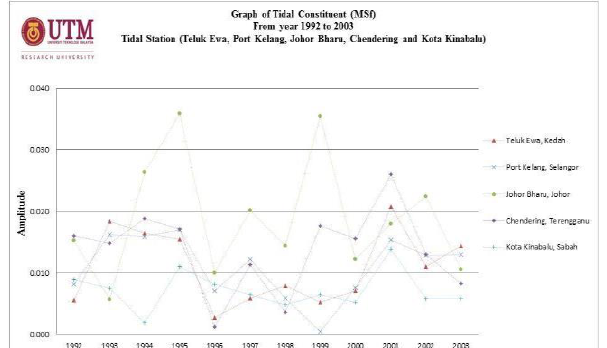
Figure 12. Graph of Tidal Constituent for MSf